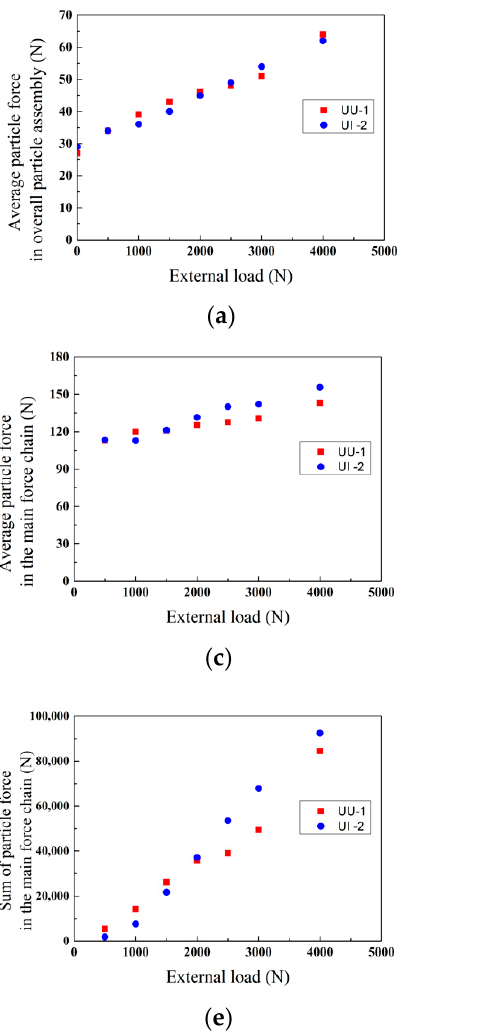
Figure 9. Changes in particle forces during load tests: ( a ) average particle force in the overall assembly; ( b ) sum of the particle force in the overall assembly; ( c ) average particle force in the main contact force chains; ( d ) frequency of the particles in the main contact force chains; ( e ) sum of the particle force in the main contact force chains.